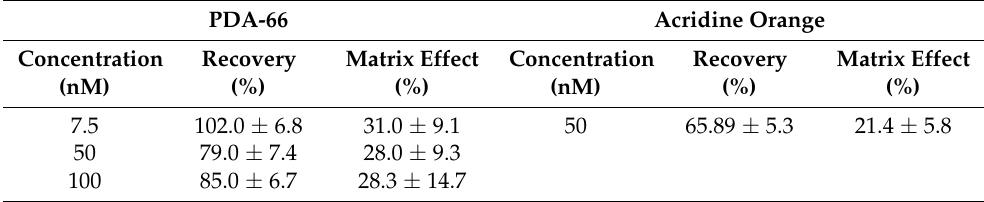
Table 2. Matrix effect and recovery of PDA-66 and the internal standard acridine orange. Values are mean percentages ± standard deviation (SD) of n = 5 (except mid and high recovery levels, n = 10). PDA-66 Acridine Orange Concentration Recovery Matrix Effect Concentration Recovery Matrix Effect (nM) (%) (%) (nM) (%) (%) 7.5 102.0 ±